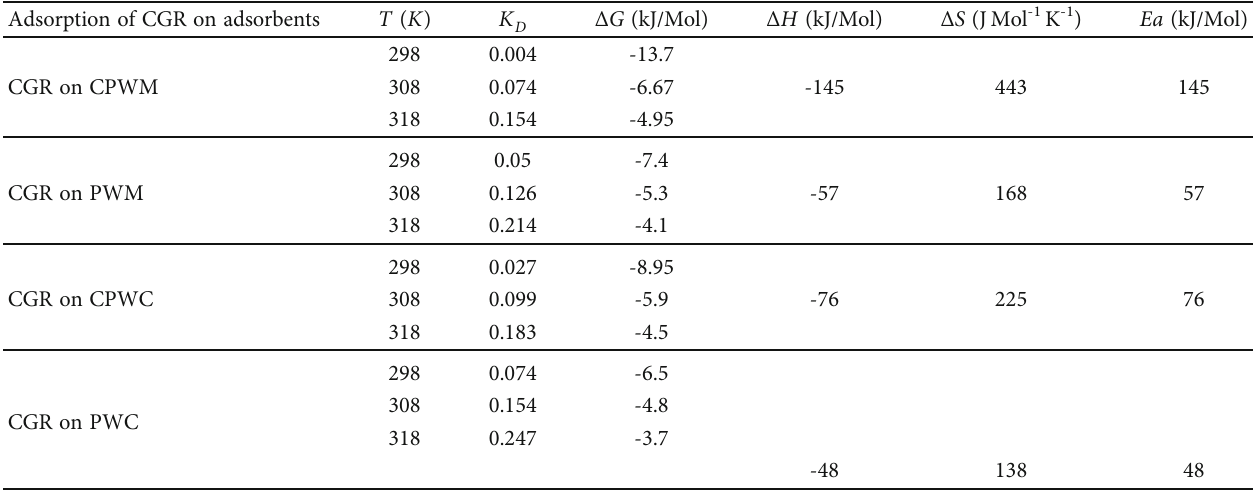
Table 5: Nonlinear comparative study of thermodynamic parameters. Adsorption of CGR on adsorbents